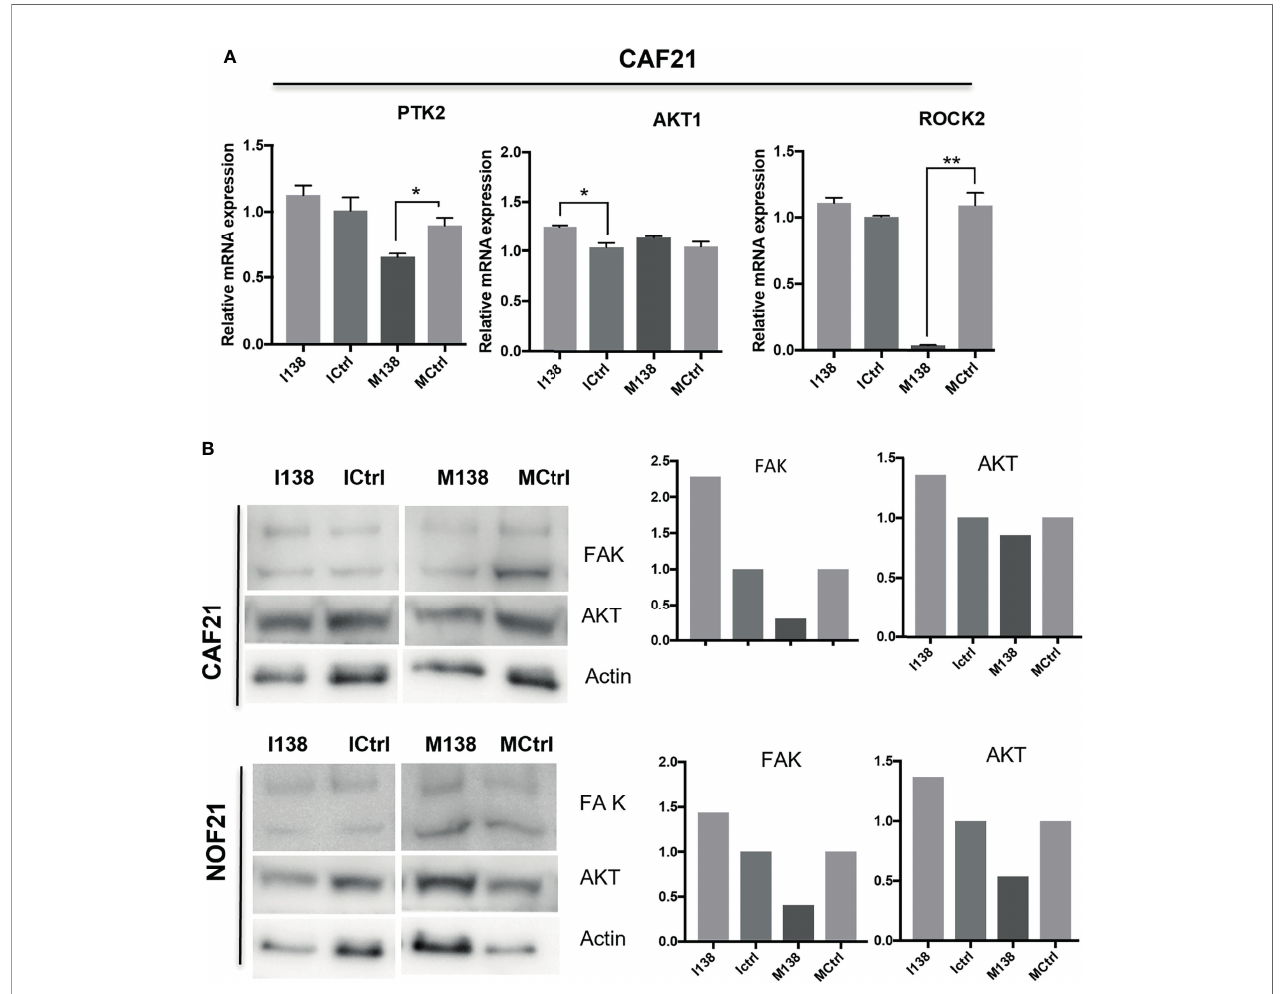
FIGURE 8 | miR-138 expression and investigation of focal adhesion kinase (FAK) axis in CAFs. Alterations in (A) mRNA and (B) protein expression of several molecules of the FAK axis following miR-204 modulation in CAFs and NOFs. (B) Western blot images and the semi-quanti fi cation of protein blots with ImageJ. * p < 0.05, ** p <